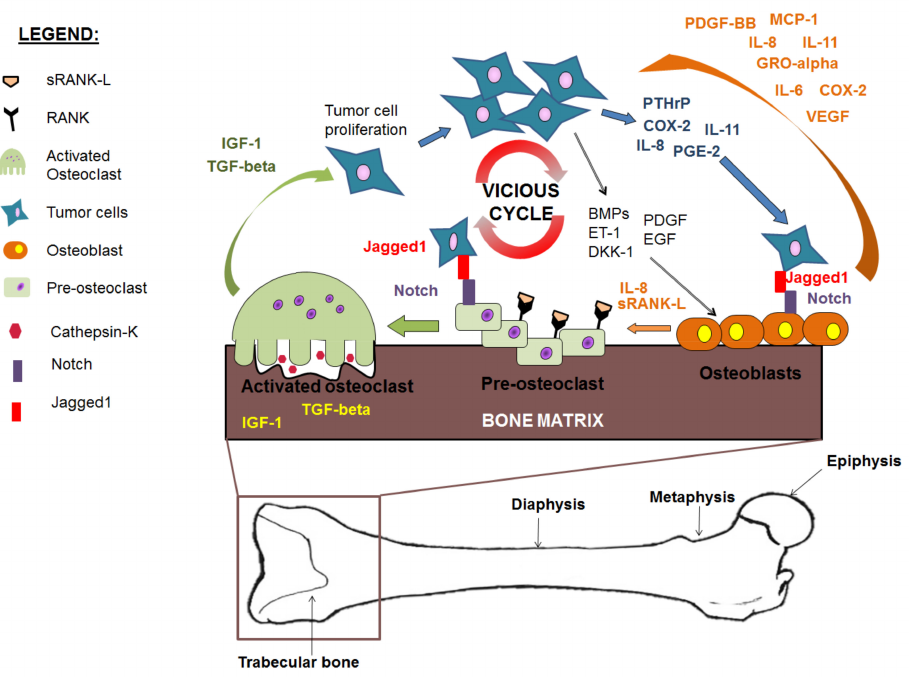
Figure 6. The ‘Vicious Cycle’ of bone degradation. In the ‘vicious cycle’ of cancer metastasis to bone, metastatic cancer cells produce parathyroid hormone related protein (PTHrP), interleukin-8 (IL-8), interleukin-11 (IL-11), prostaglandin E2 (PGE2), and cyclooxygenase-2 (COX-2) (lytic and blastic cancers) as well as bone morphogenic proteins (BMPs), endothelin-1 (ET-1), dickkopf-1 (DKK-1), platelet-derived growth factor (PDGF), and epidermal growth factor (EGF) (blastic cancers). These factors promote increased osteoblast production of interleukin-6 (IL-6), IL-8, monocyte chemoattractant protein-1 (MCP-1), vascular endothelial growth factor (VEGF), growth related oncogene-alpha (GRO-alpha), IL-11, and COX-2 that act as chemoattractants, maintenance, and survival factors for lytic metastatic cancer cells. Growth factors, including VEGF, insulin growth factor-1 (IGF-1), platelet-derived growth factor-BB (PDGF-BB), and tumor-growth factor-beta (TGF-beta) as produced by osteoblasts serve to promote proliferation of blastic cancers. Osteoblasts also produce increased amounts of soluble receptor activator of nuclear factor kappa beta-ligand (RANK-L), which binds to RANK receptors on pre-osteoclasts to initiate osteoclastogenesis. Furthermore, breast cancer cells that express Jagged1 ligand bind to the Notch receptor on osteoblasts leading to increased osteoblast-derived RANK-L expression and increased osteoclast activation. Jagged1 expressing breast cancer cells can also bind to the Notch receptor on pre-osteoclasts and initiate osteoclastogenesis independent of RANK-L. Activated osteoclasts resorb bone by secretion of proteases including cathepsin K into resorption pits, and release TGF-beta and IGF-1 from the bone matrix. TGF-beta and IGF-1 act on metastatic tumor cells to promote proliferation and continued expression of PTHrP, IL-8, IL-11, PGE2, COX-2, BMPs, ET-1, DKK-1, PDGF, and EGF from cancer